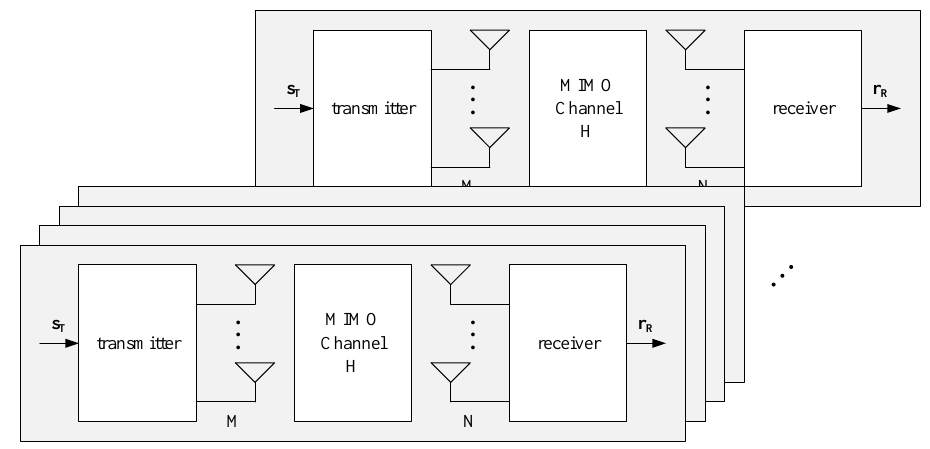
Figure 8. Signal model of the generic multiple-input multiple-output (MIMO) video